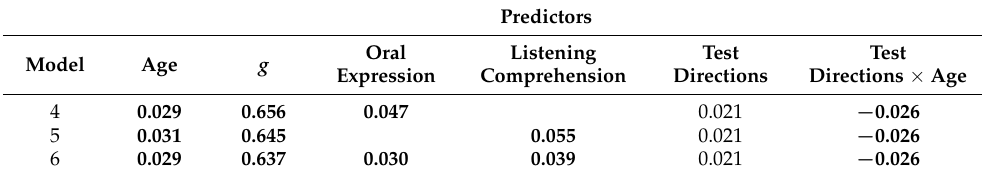
Table 3. Standardized Beta Coefficients for Models 4, 5, and 6.